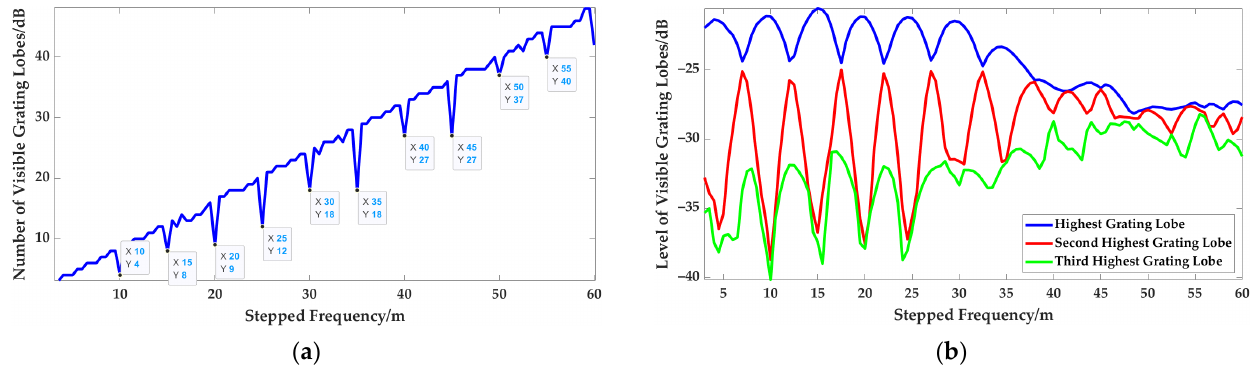
Figure 16. Experimental result of the effect of step frequency on visible grating lobes: ( a ) relationship between the number of the visible grating lobes and step frequency; ( b ) relationship between the levels of the visible grating lobes and step frequency.